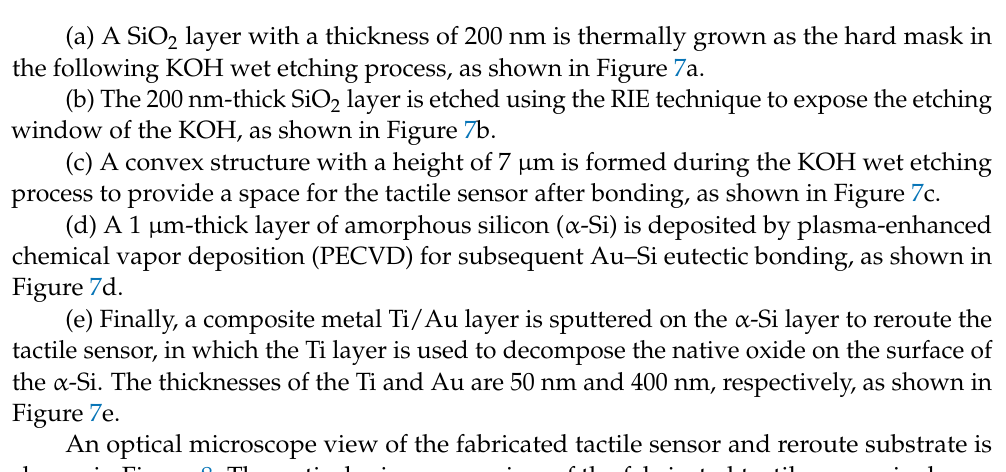
Figure 8. Optical microscope view of fabricated tactile sensor and rerouted substrate. ( a ) Optical microscope view of the fabricated tactile sensor; ( b ) enlarged optical microscope view of the temporary supported beam of the fabricated tactile sensor; ( c ) enlarged optical microscope view of the silicon nitride diaphragm of the tactile sensor; ( d ) optical microscope view of the fabricated reroute substrate. To analyze the stiction of the fabricated tactile sensor further, scanning electron mi- croscopy (SEM) was employed. The SEM view of the temporary supported beam of the fabricated tactile sensor is shown in Figure 9. Figure 9b shows an enlarged view of the temporary supported beam shown in Figure 9a. As the Figure shows, the temporary sup- ported beam is temporarily bonded to the substrate owing to the stiction effect.